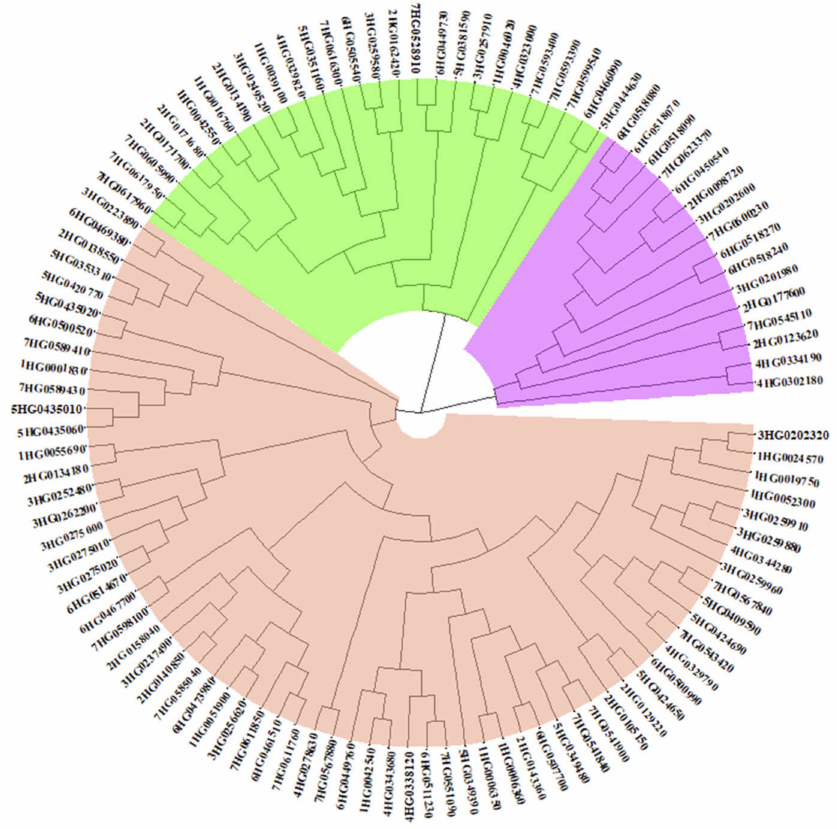
Figure 3. Phylogenetic tree obtained for the 108 HvMADS-box genes. A total of 108 protein sequences were identified and annotated as MADS-box transcription factors. The genes names in the tree derived from their names in the barley reference genome, e.g., 5HG0409590 corresponds to